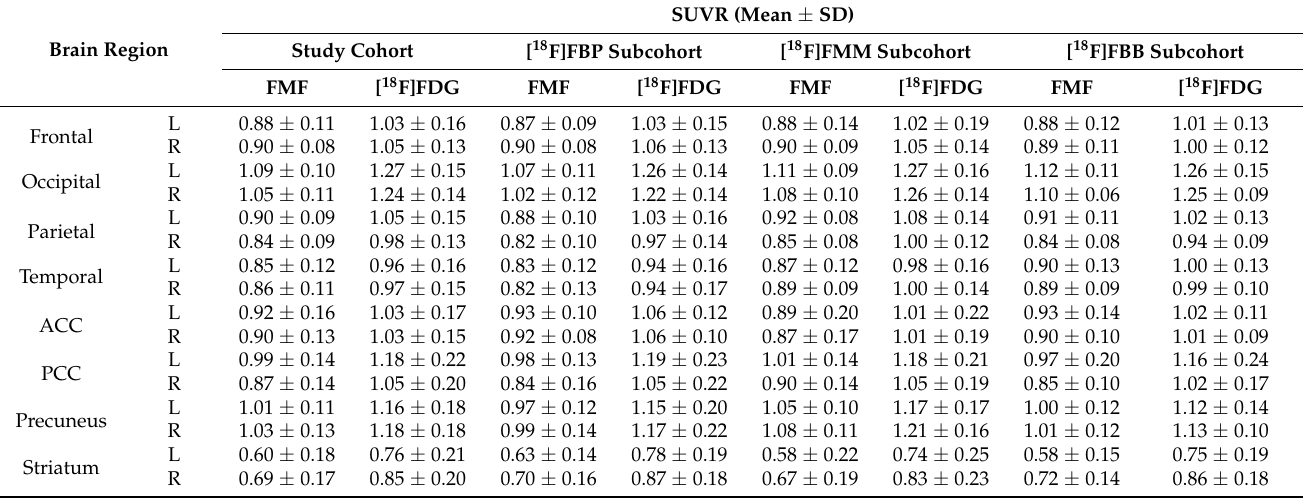
Figure 2. The correlation coefficient is r = 0.98 ( p < 0.001) for all patients and in the [ 18 F]FBB subcohort, and r = 0.97 ( p < 0.001) in the [ 18 F]FBP and [ 18 F]FMM subcohorts. Correlation coefficients between intensity profiles in A β + and A β − patients range from r = 0.96 ( p < 0.001) to r = 0.98 ( p < 0.001). Regional SUVRs, intensity profile graphs, and correlation charts with the respective correlation coefficients of the A β + and A β − subcohorts can be found in Section S2.1 of the Supplementary